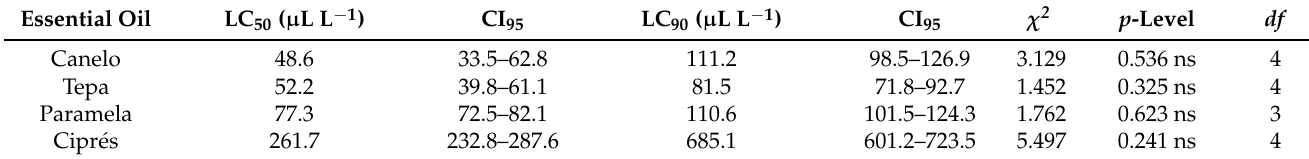
Table 4. Insecticidal activity of the four essential oils from Patagonian plants against 3rd-instar larvae of Culex quinquefasciatus; df = degrees of freedom, ns = not significant (p > 0.05)